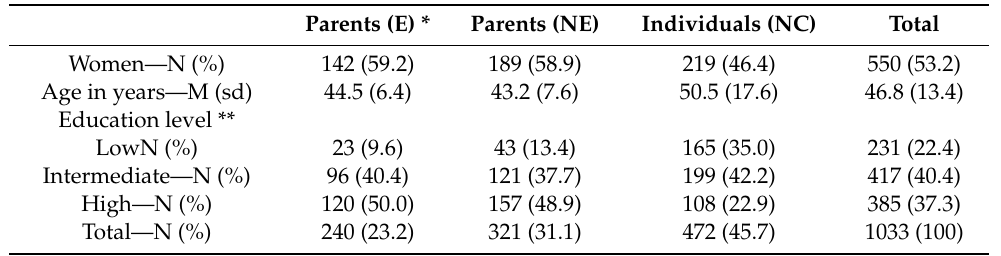
Table 2. The study population at T1: gender, age (mean and standard deviation) and education level per population